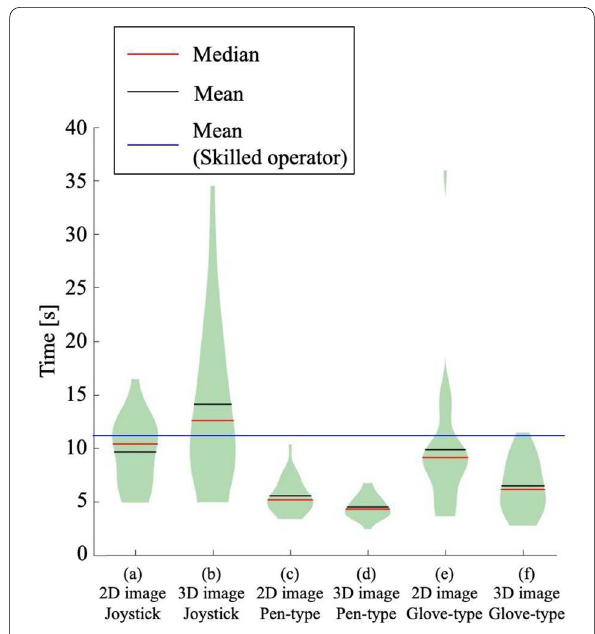
Fig. 20 Violin plots of the time